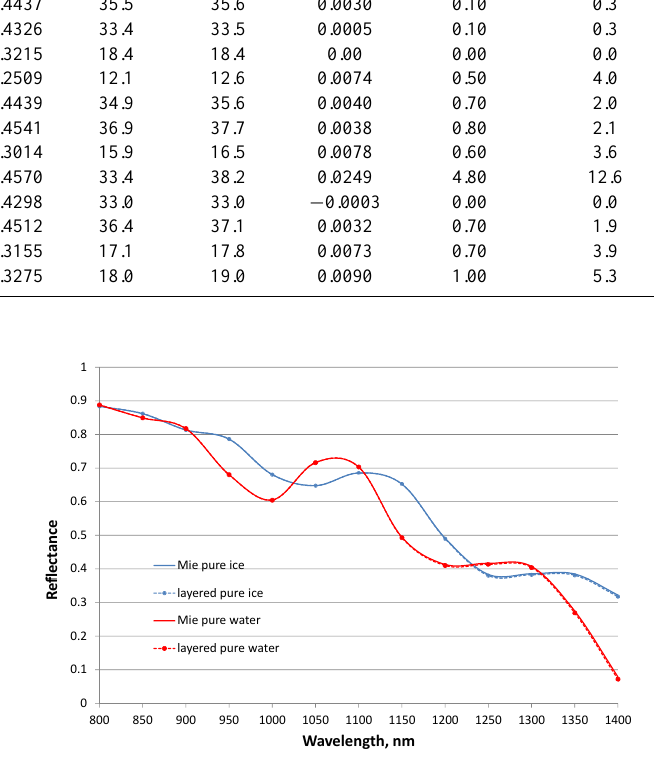
Figure 2. Reflectance calculated with both codes for snow of and an optically semi-infinite